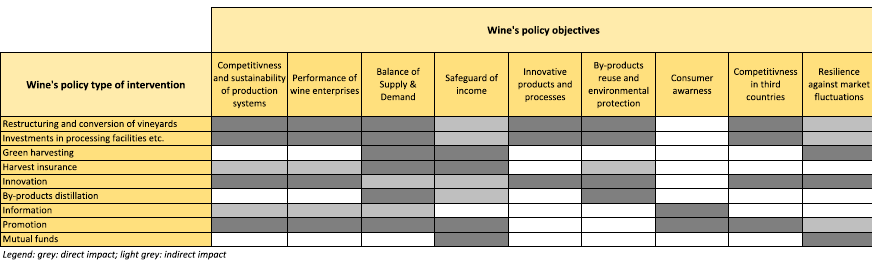
Table 9 Wine sectoral policy objectives and sectoral types of intervention (2021 –